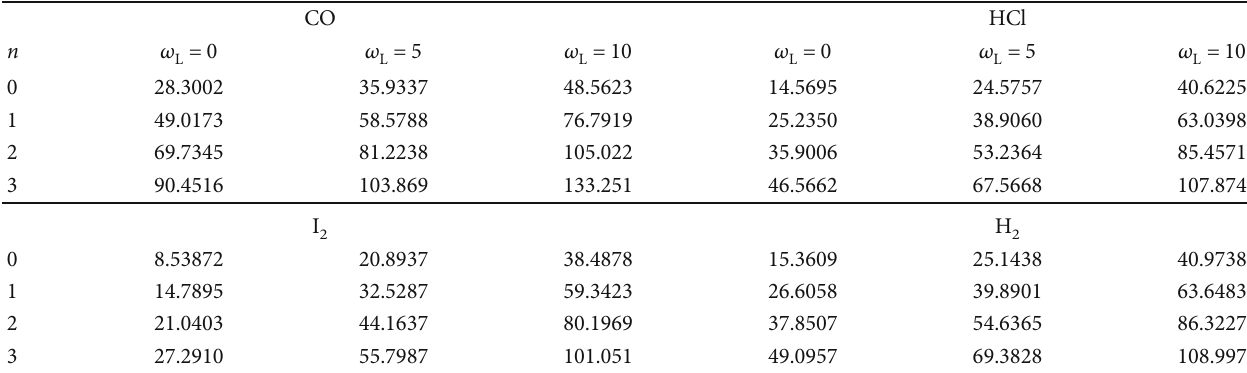
, and H molecules bounded by the isotropic oscillator plus inverse quadratic potential for 2 2